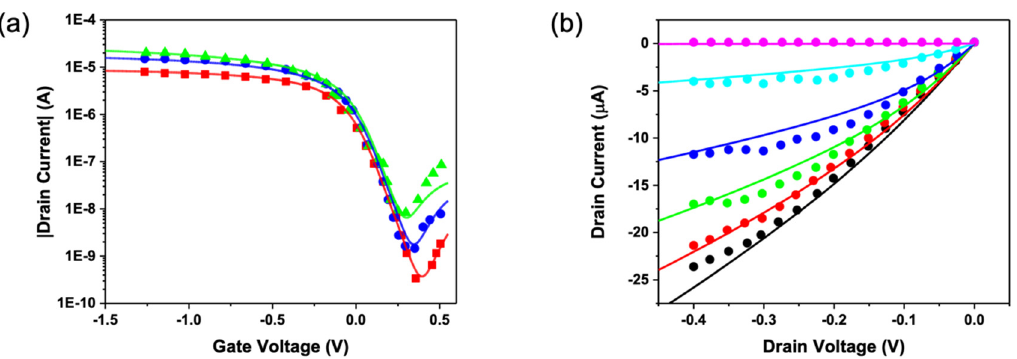
Figure 2. Measured [19] (symbols) and simulated (lines) drain currents for the CNTFET compact model. ( a ) Transfer characteristics at drain voltage, V ds = − 0.1, − 0.2, and − 0.3 V. ( b ) Output characteristics at the gate voltage, V gs from − 1.3 to 0.2 V in 0.3 steps.